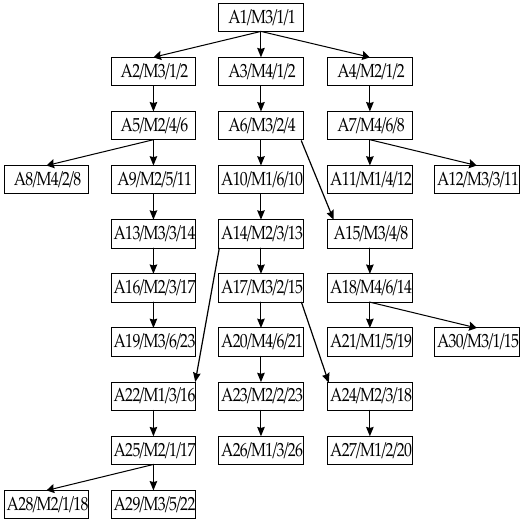
Figure 1. ROPT of product A.